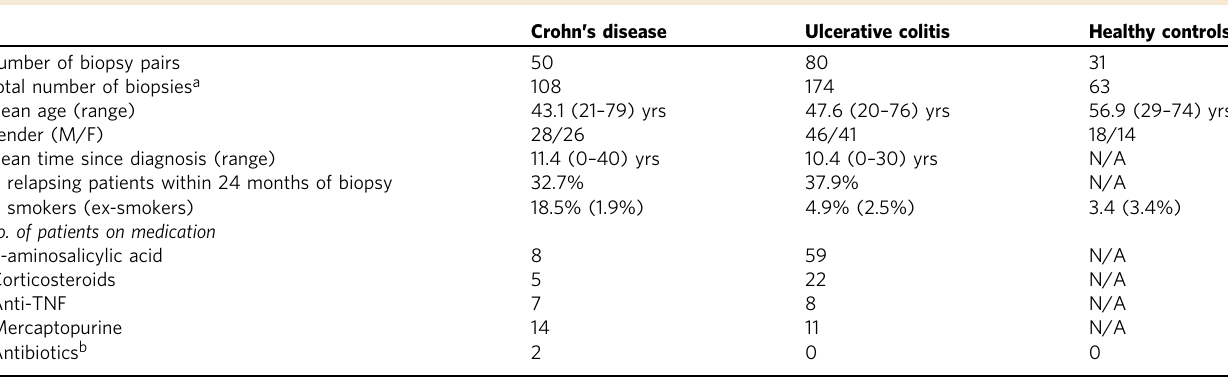
Table 1 Subject characteristics across the three